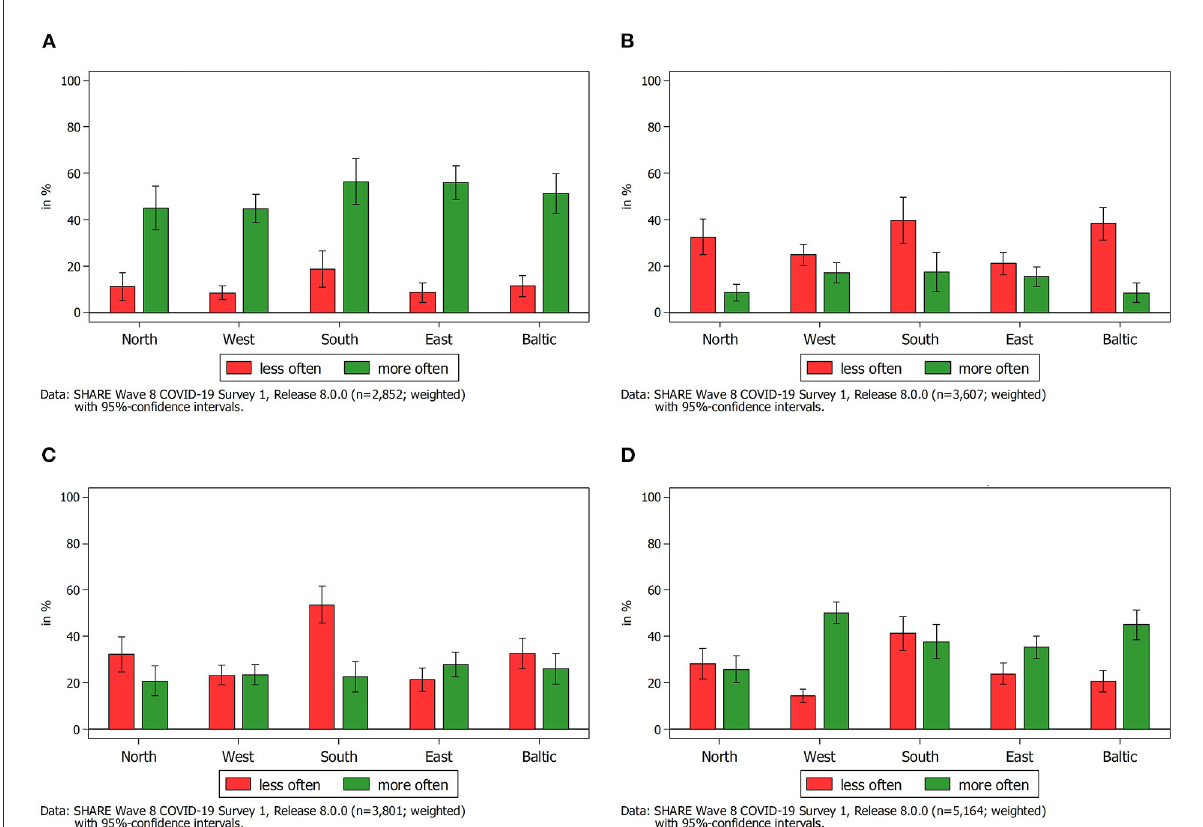
FIGURE2 Change in frequency of providing help to someone outside the own household since the outbreak of the pandemic in 2020 by type of relationship. (A) Help provided to parents outside the household since the outbreak of the pandemic. (B) Help provided to children outside the household since the outbreak of the pandemic. (C) Help provided to other relatives outside the household since the outbreak of the pandemic. (D) Help provided to other non-kin outside the household since the outbreak of the